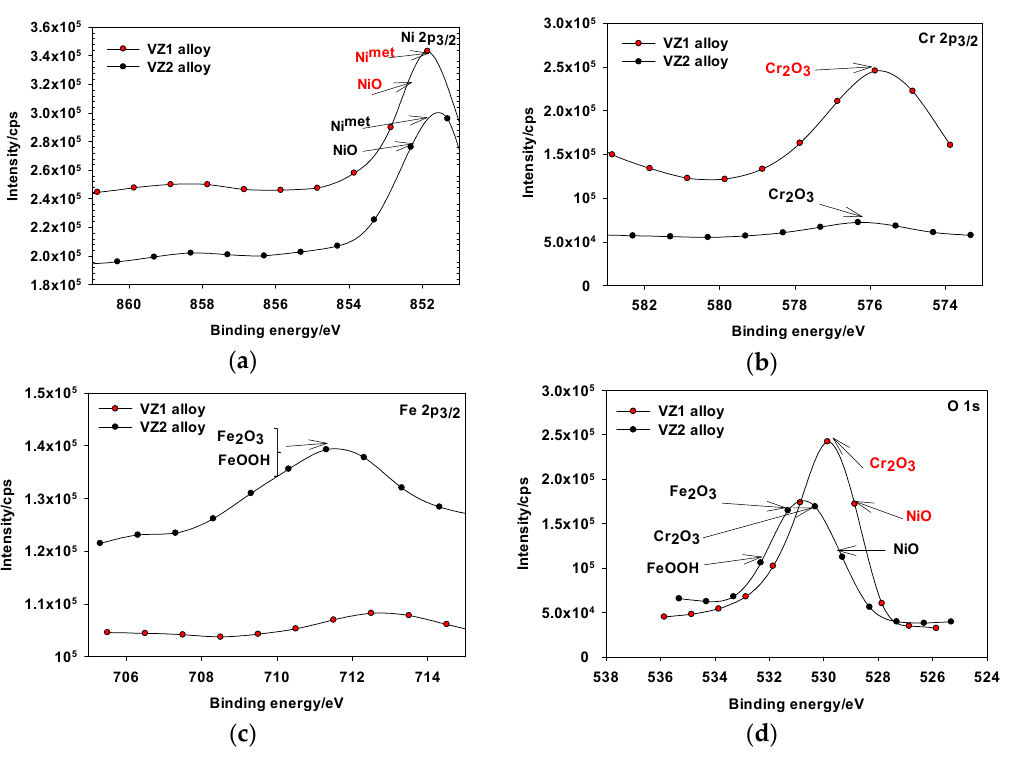
Figure 5. XPS spectra detected for the passive film formed on Ni-base glassy alloys in 1.0 M NaOH solution at 27 °C: ( a ) Ni 2p 3/2 spectrum of the VZ1 and VZ2 alloys; ( b ) Cr 2p 3/2 spectrum of the VZ1 and VZ2 alloys; ( c ) Fe 2p 3/2 spectrum of the VZ1 and VZ2 alloys; ( d ) O 1s spectrum of the VZ1 and VZ2 alloys.